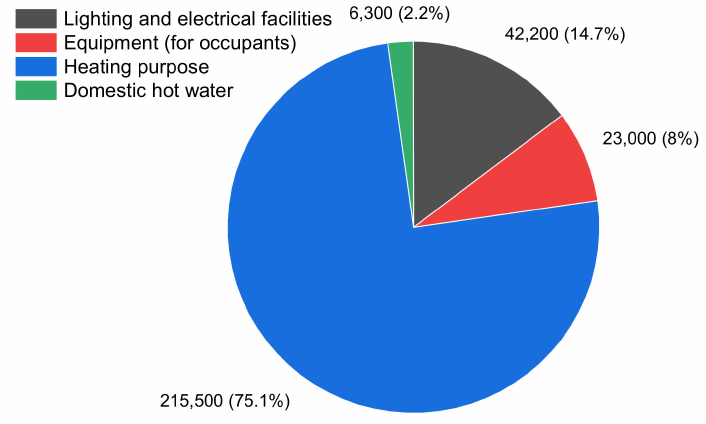
Figure 9. Breakdown of the building’s annual energy consumption (kWh) for the base model simulation (case A).